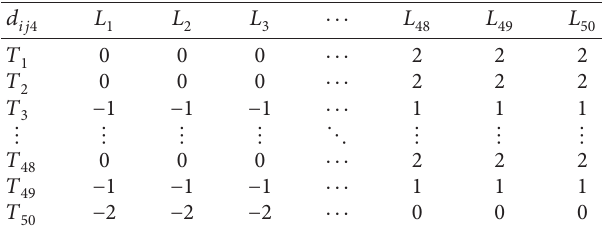
Table 22: Profit and loss matrix D